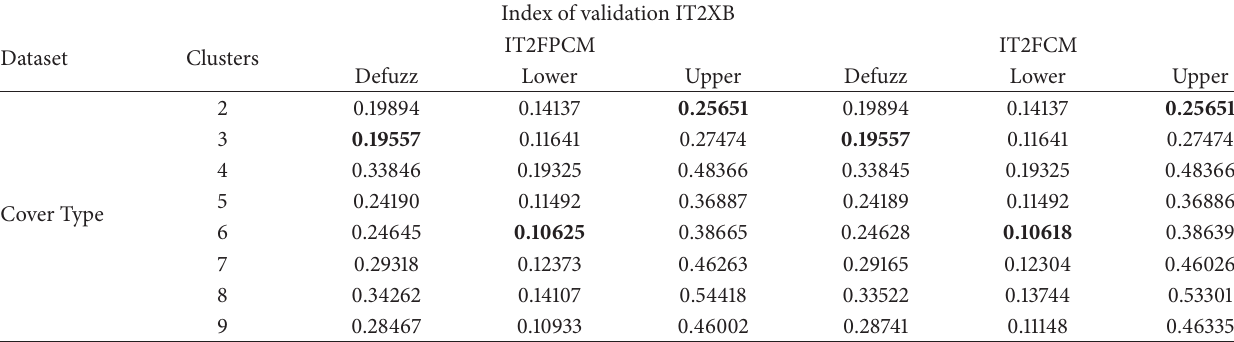
Table 23: Results of the IT2XB validation index to Cover type dataset clustering using IT2FPCM and IT2FCM algorithm with 𝑚 = [1.5, 2.5] and 𝜂 = [1.5, 2.5] as parameters.